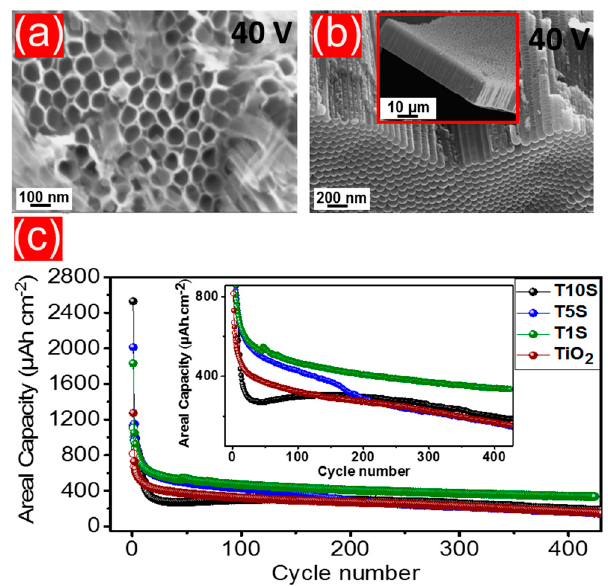
Figure 17. ( a ) SEM micrographs of the TiSn 1 alloy anodized at 40 V for 5 h; ( b ) Cross-sectional view of the nanotubes grown at 40 V. The inset in (b) shows the uniform growth of the nanotubes. ( c ) Galvanostatic cycling obtained at a current density of 504 mA cm − 2 for pure TiO 2 (dark red circles) and TiO 2 /SnO 2 anodes. T1S (green circles), T5S (blue circles), and T10S (black circles) correspond to the nanotubes prepared on the TiSn 1 , TiSn 5, and TiSn 10 alloy substrates, respectively, adapted